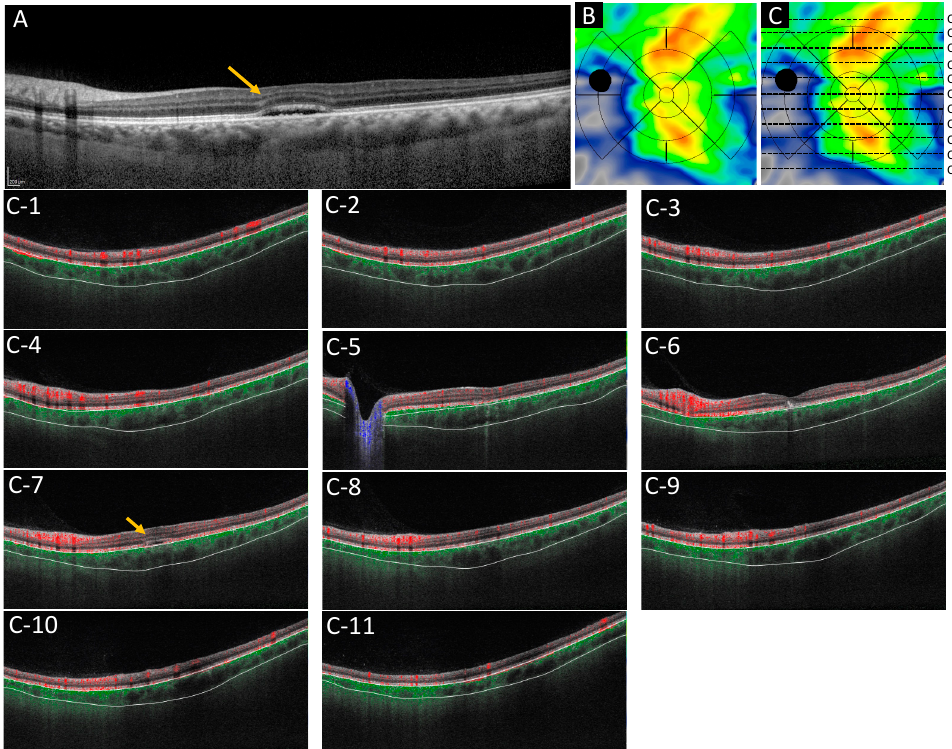
Figure 7. Images of choroidal volume map. ( A ) Shows the optical coherence tomography horizontal scan diagnosed chronic serous chorioretinopathy. ( B ) Shows the choroidal volume map in this case. ( C ) Shows each localization in which measurements were done. ( C-1 – C-11 ) Show the choroidal-scleral interface by scan from top to bottom in the image, corresponding to each line drown in ( C ). It is segmented correctly. The color map display ranges from 0 to 800 microns. The arrows show the subretinal